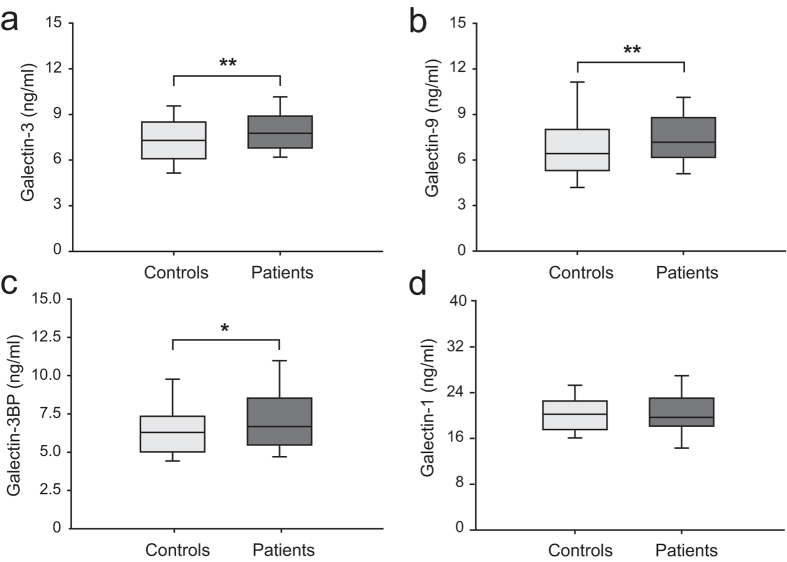
Comparison of the serum levels of galectin-1, -3, -9, and -3BP in the patients and controls.In the box-and-whisker plots, the lower and upper ends of the box represent the 25th and 75th percentiles, respectively; the horizontal line inside the box represents the median value; and the peripheral lines extending to the outer fences represent the 10th and 90th percentiles. Differences between the two groups were compared using Student’s t-test (a,b,d) or the Mann-Whitney U test (c). *p < 0.05, **p < 0.01. Abbreviations: galectin-3BP, galectin-3 binding protein.